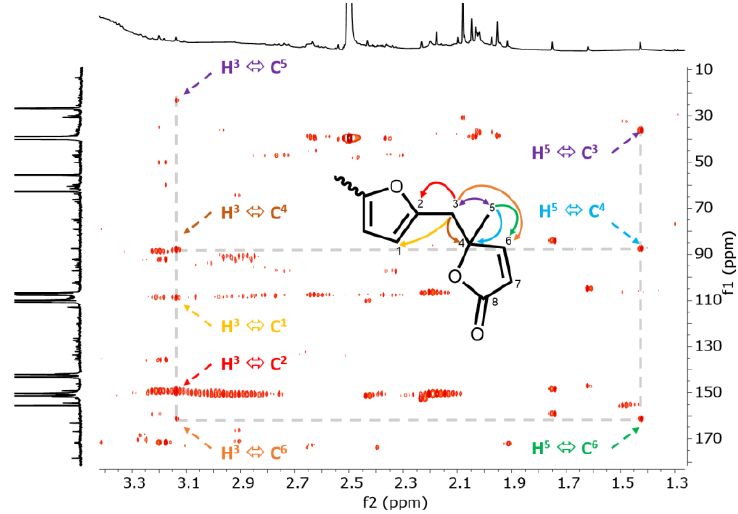
Figure 7. Magnified HMBC spectrum of PFA° at a conversion degree of 0.76.